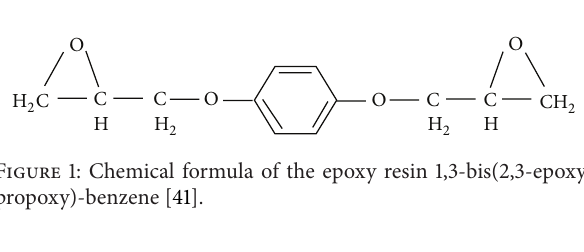
Figure 2: Chemical formula for unsaturated